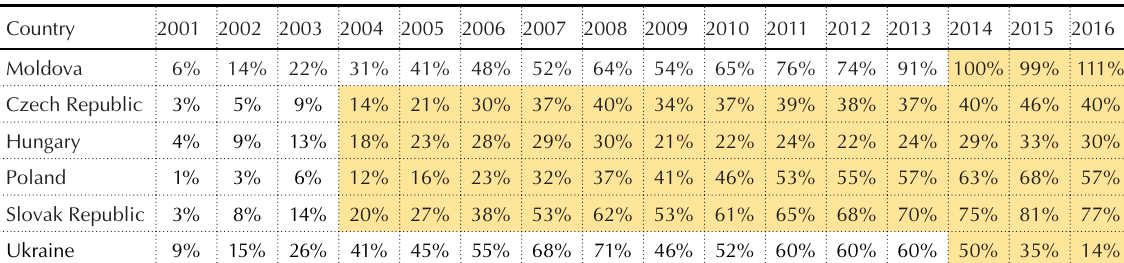
Table 1. Dynamics of GDP in Ukraine, Moldova and Visegrad Group (in comparison with 2000), % Source: Data from database: World Development Indicators, December 10,